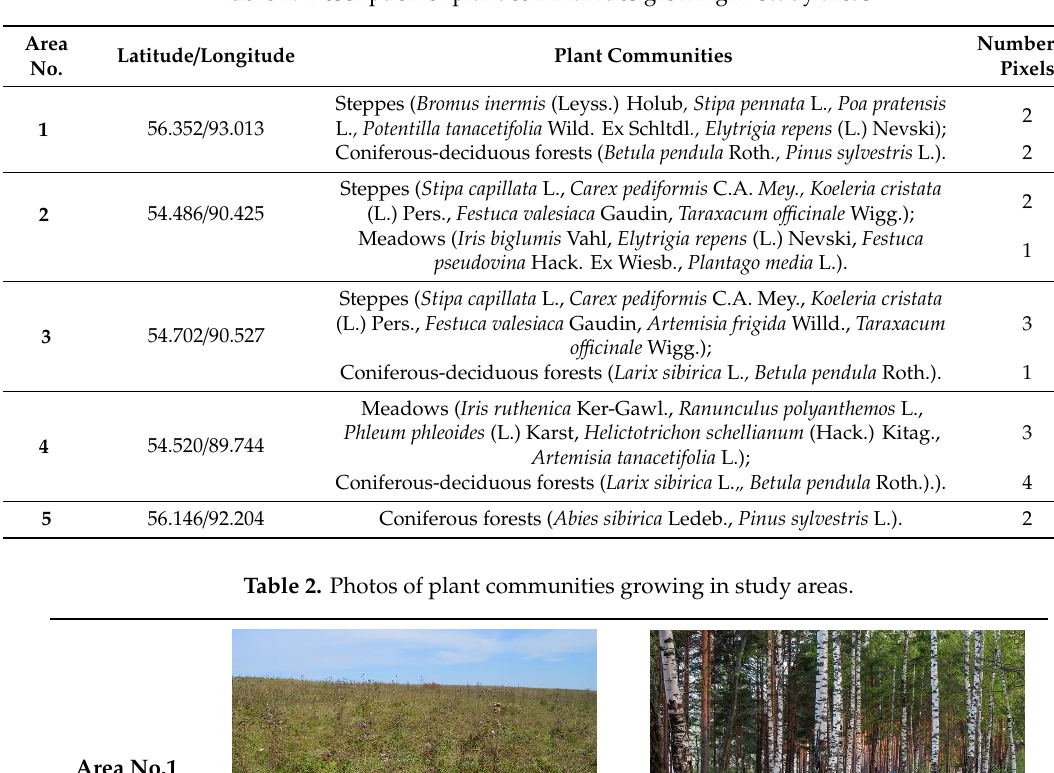
Table 1. Description of plant communities growing in study areas.